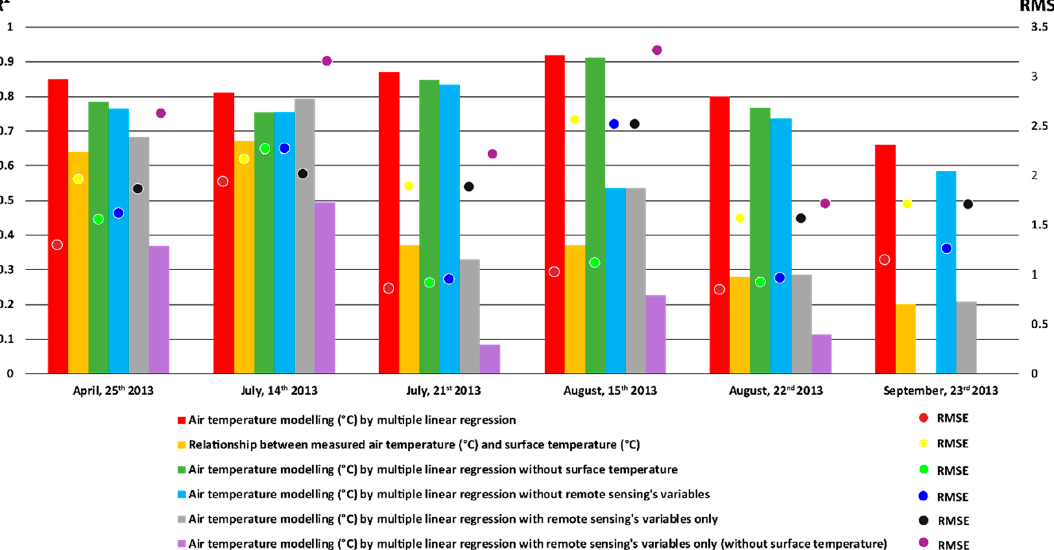
Figure 7. Results of the different modelling of air temperature over the entire study area: R 2 on the left axis; Root-Mean-Square Error (RMSE) on the right axis).